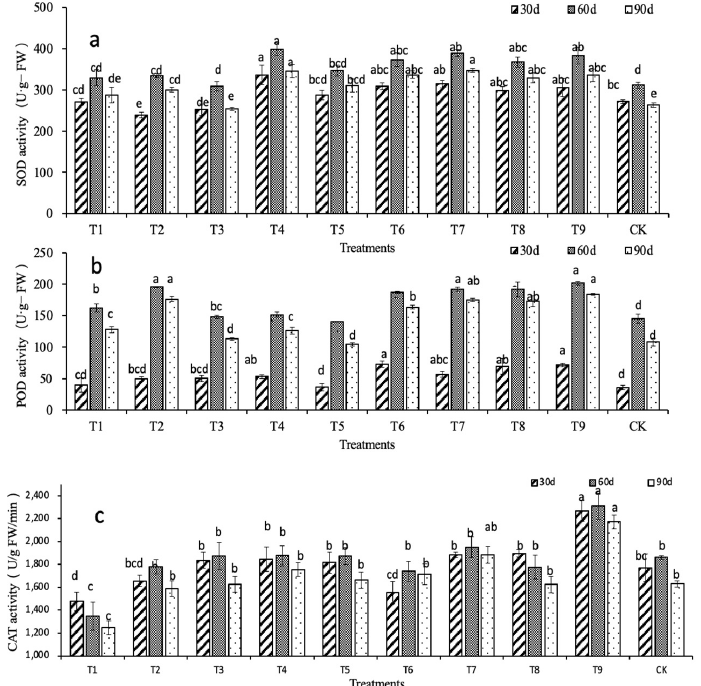
Figure 3. Effects of nitrogen, phosphorus, and potassium on the antioxidant system activity of D. denneanum . ( a ) SOD activity. ( b ) POD activity. ( c ) CAT activity. Lowercase letters indicate inter group significance ( p < 0.05).